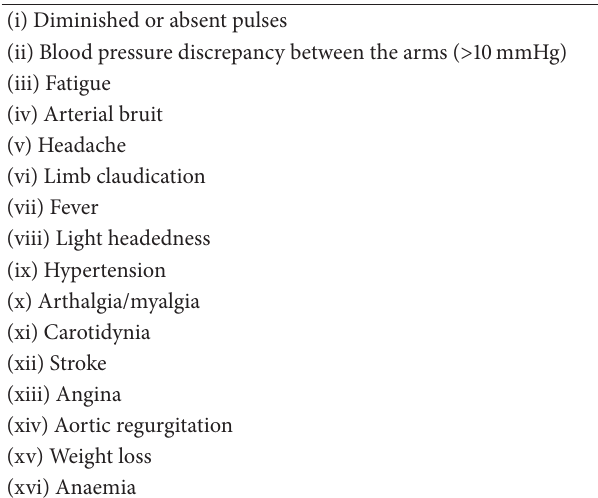
Table 1: Common disease